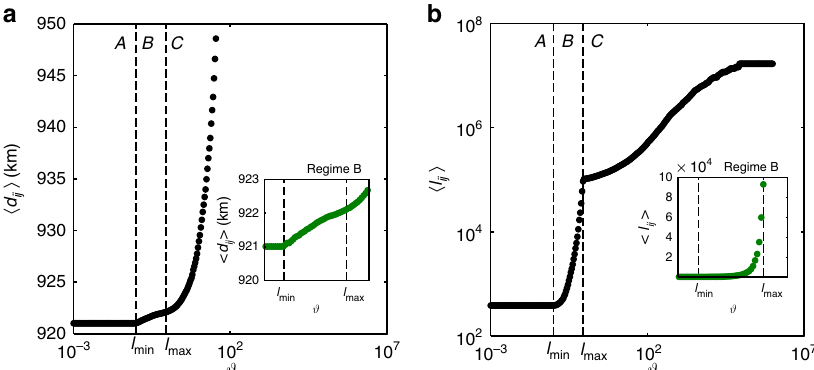
Figure 2 | Average shortest path h d ij i in km and average load h l ij i dependence on cost ! . We observe three different regimes as a function of the cost. In ( a ), the average shortest path length remains relatively stable while the load (a proxy for benefit) as shown in ( b ) increases drastically in regime B. The insets of both figures are blow-ups of regime B. In ( a ), a slight increase in the shortest path in regime B is observed, while in ( b ) the benefit increases by a large magnitude pointing to the inevitable compromise between connectivity and profit. Data are averages over 100 realizations.